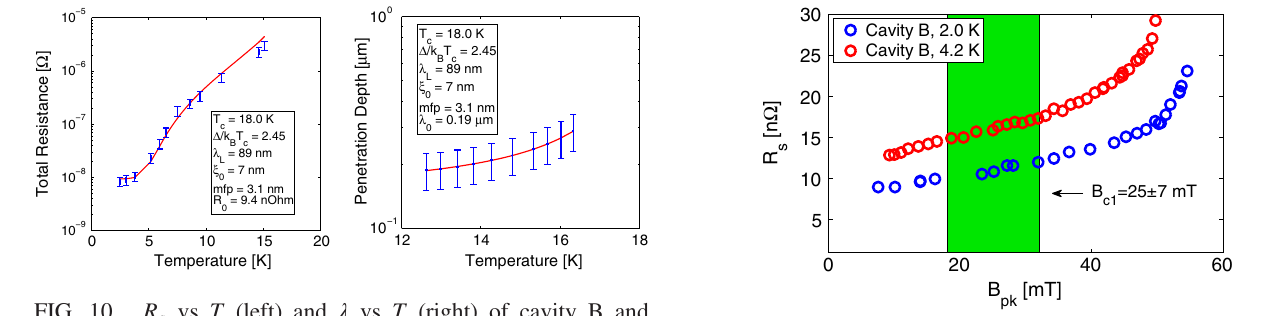
FIG. 11. R s vs B curves of cavity B compared to the measured B c 1 , which the cavity clearly exceeds without a significant increase in R s .